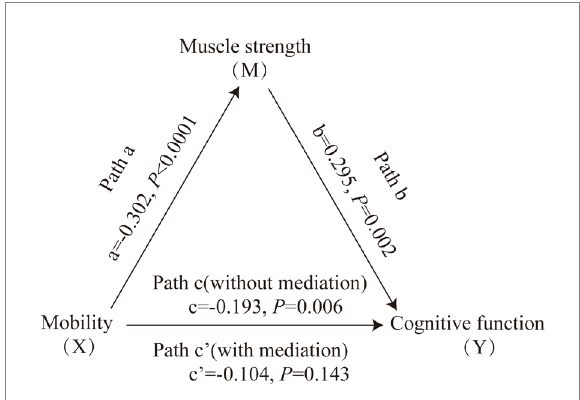
FIGURE 3 Mediating role of muscle strength on the relationships between mobility and cognitive function in community-dwelling older adults with cognitive impairment. The capital letters X, M, and Y were used to represent mobility, lower extremity muscle strength and cognitive function, respectively. The mediating effect tested the four following pathways (regression coefficients): mobility on muscle strength (Path a), muscle strength on cognitive function (Path b), mobility on cognitive function without medication (Path c), mobility on cognitive function with medication (Path